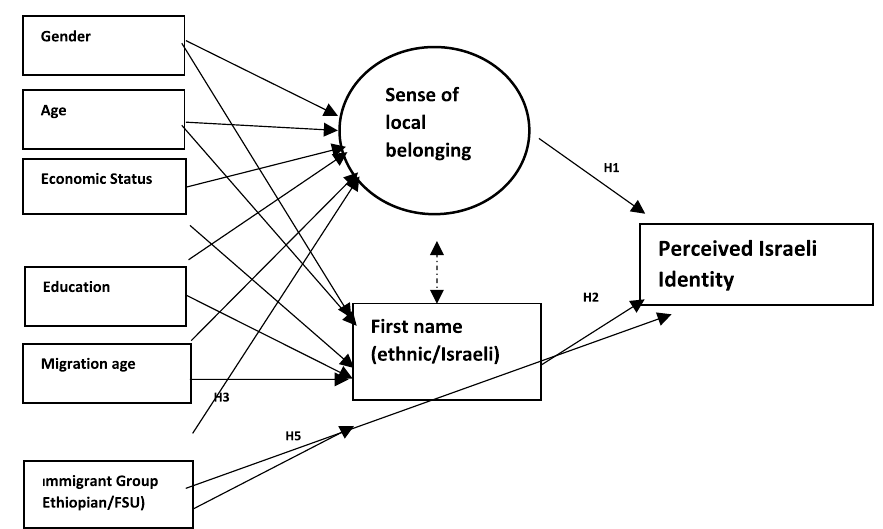
Fig. 1 The research general predicting